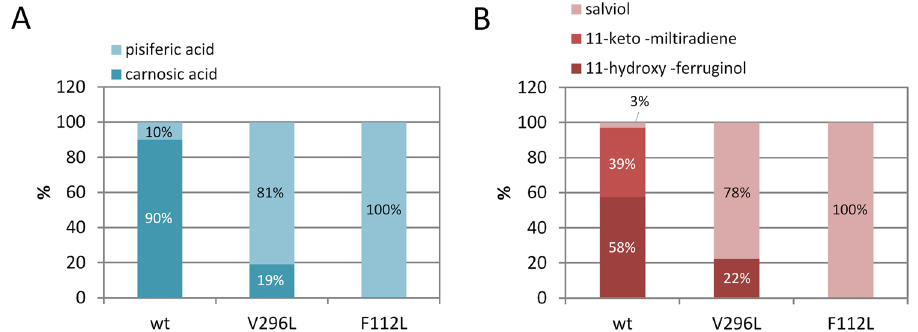
Figure 4. Redirecting biosynthetic fluxes towards specific compounds by engineering CYP76AH24 specificity. ( A ) Biosynthetic shift from carnosic acid to pisiferic acid production in yeast cells. ( B ) Abolishing undesirable production of 11-keto-miltiradiene and 11-hydroxy-ferruginol production in yeast to favor biosynthesis of